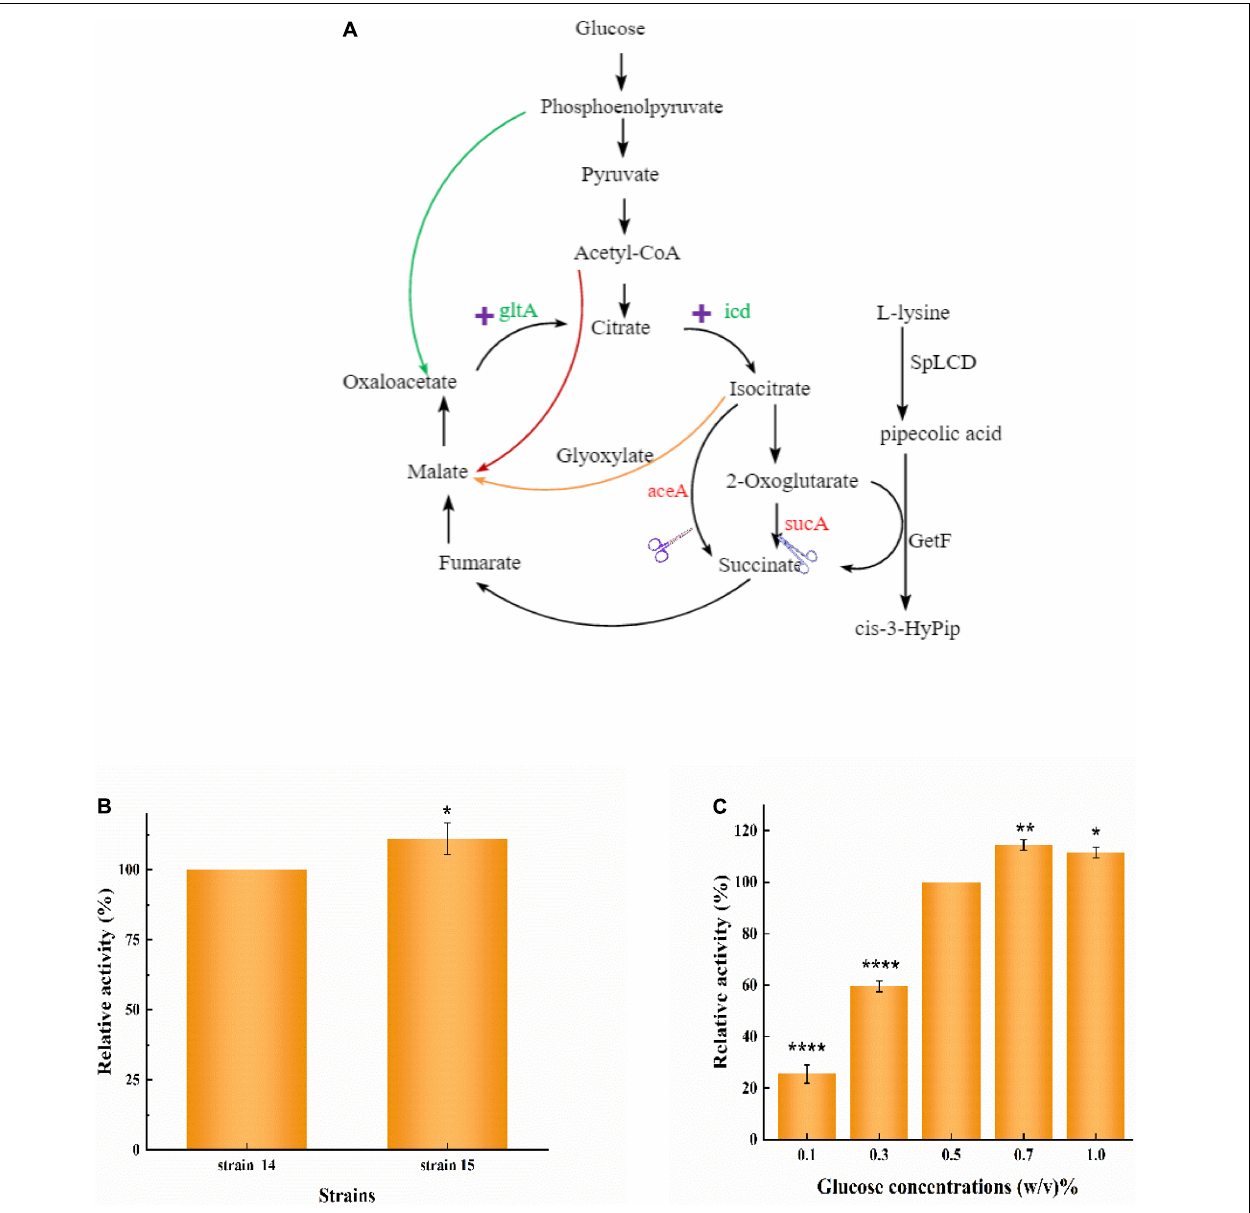
FIGURE 5 | Increase whole-cell activity for cis-3-HyPip production by over-accumulation of 2-OG. (A) The combined manipulations to convert E. coli into an efficient whole-cell biocatalyst for cis-3-HyPip production. (B) Effect of overexpressing glta and icd on whole-cell catalysis. Strain 15 [ E. coli BL21(DE3) (cid:77) sucA (cid:77) aceA pETduet-1-29- getf -RBS(T7)- splcd &pCDF- glta - icd ], Strain 14 [ E. coli BL21(DE3) (cid:77) sucA (cid:77) aceA pETduet-1-29- getf -RBS(T7)- splcd ]. (C) Effects of glucose concentrations on whole-cell (strain 15) catalysis. *P < 0.05, **P < 0.01, **** P <